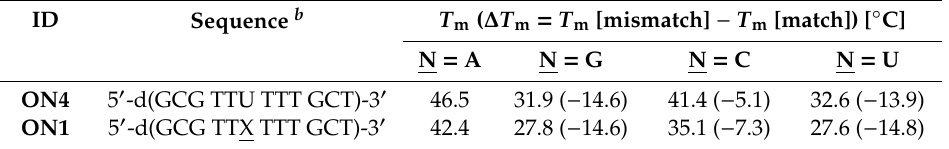
Table 5. Mismatch discrimination of natural and OxNorNA-modified oligonucleotides toward ssRNA a. ID